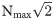
Examples of GARD simulations under different β’s.(A1-C1) Histories of different tapes; For each tape, assemblies from different generations are plotted along the X axis, and color represents the counts of each of the NG molecule types in each assembly (recorded at assembly size Nmax (Fig 1). Tapes are separated by a vertical black line. For each tape, the first 1,000 assemblies are shown. Red color represents counts ≥ 50, and for brevity counts < 5 are colored white. (A2-C2) Density plots; For each assembly shown in panels (A1-C1), its Euclidean distance and angle vs. the eigenvector of the full-β was calculated (normalized for the maximum value between two assemblies, Nmax2 for distance and 90 degrees for angle). Color is normalized probability (log10 scale) of an assembly having a certain angle and distance. See section: Compotype-community assignment. (A3-C3) Same as (A2-C2), except for each assembly the distance and angle are calculated against the one eigenvector of β* which has the lowest angle to this assembly. Number of Infomap communities detected is: 9 (A3), 7 (B3) and 6 (C3). Further examples are available at http://ico2s.org/data/extras/gard/ and [73].